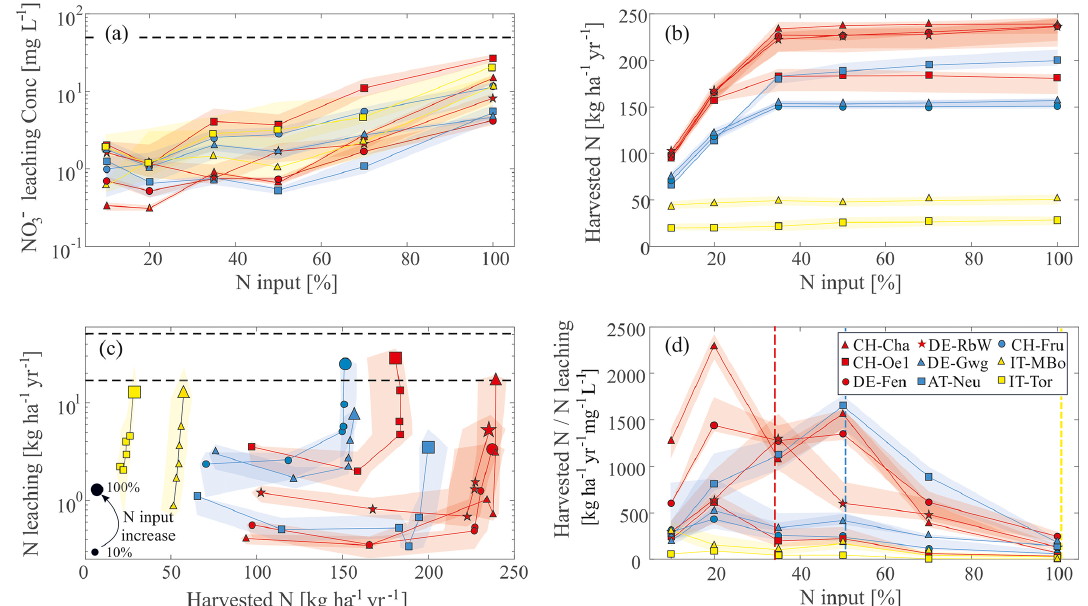
Figure 6. Results of the fertilization experiments. (a) NO − concentration in groundwater recharge as a function of different nitrogen fertiliza- 3 tion scenarios (percentage of the maximum) in each site. (b) Harvested N in each site as a function of different nitrogen fertilization scenarios. (c) Harvested N vs. N leaching in each site. Moving counterclockwise follows the increase in N input. As a reference, the biggest marker indicates N input of 100%. The dotted lines represent the estimate of maximum NO − losses assumed by EU regulations or nearby countries. 3 They correspond to the values 17 and 51kgNha − 1 yr − 1 , i.e., 10% and 30% of the maximum allowed input of 170kgNha − 1 yr − 1 . (d) N fertilization efficiency index computed as the ratio between the harvested N and N concentration in groundwater recharge as a function of nitrogen input. In all the subplots the colors represent the elevation class, i.e., pre-Alpine (red), Alpine (blue), and high-Alpine (yellow) sites. The colored area around the markers and lines represent the 25th and 75th percentiles of the interannual variability of the simulated variables, while the colored lines connecting data points represent the median values. The vertical dashed bars represent the limit of 170kgNha − 1 yr − 1 imposed by the EU Nitrate Directive in each of the three